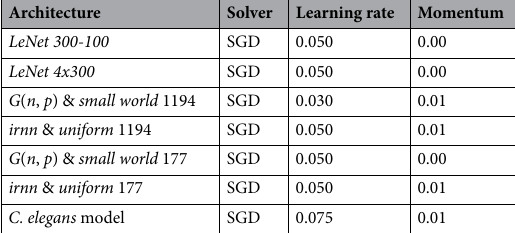
Table 8. Solver parameter for different architectures.